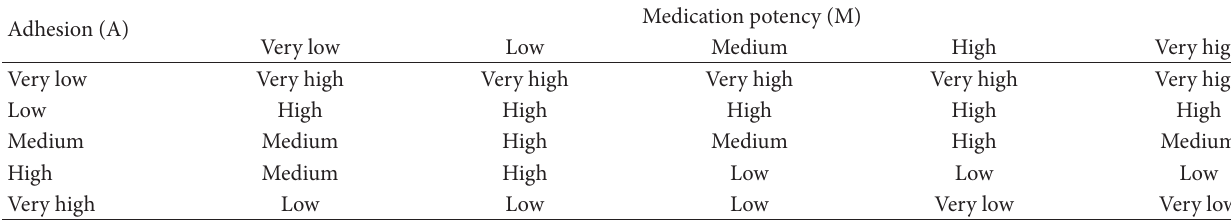
Table 1: Fuzzy rules for the percentage of CD4+ cells that will be infected.